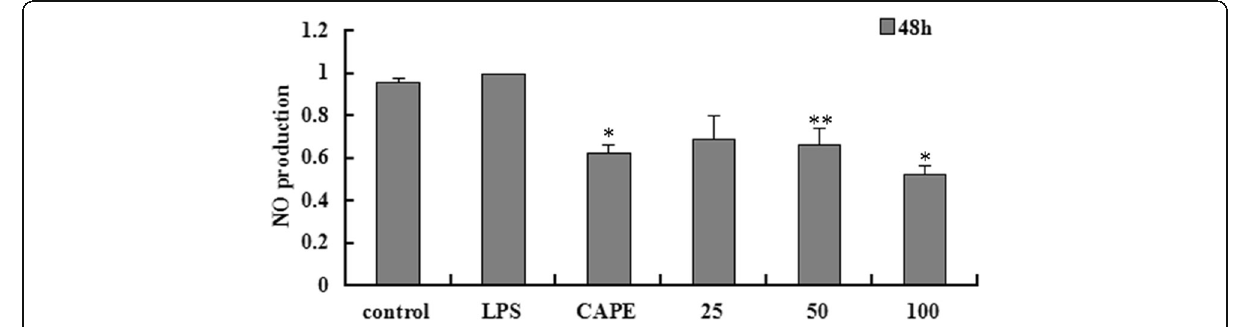
Fig. 4 EECP and CAPE inhibited NO production at 48 h. ( * P < 0.05, ** P < 0.01 vs control, n = 3). Data are means ±